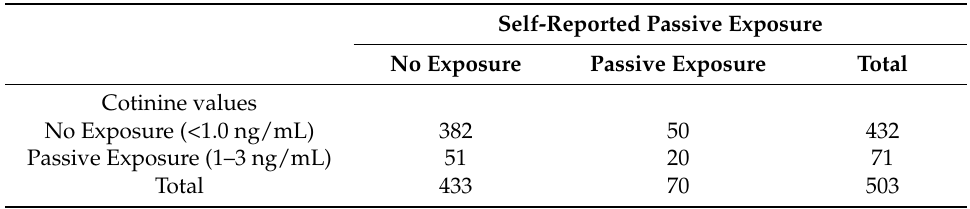
Table 3. Comparison of self-report passive exposure to cotinine